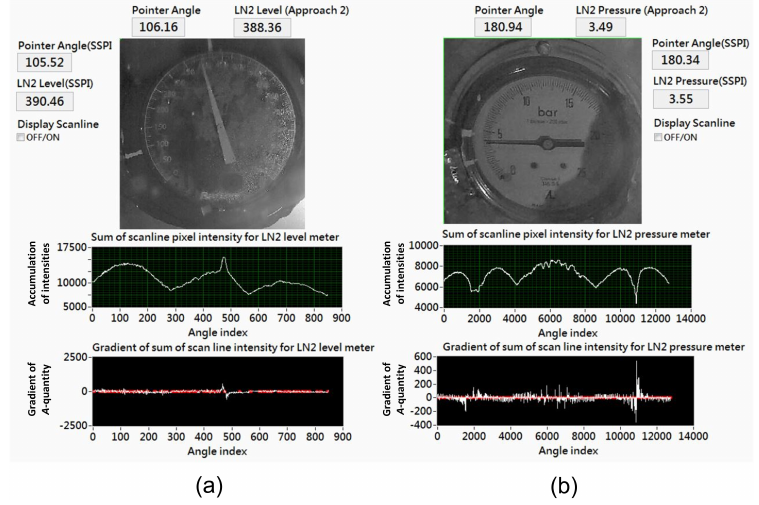
Figure 26. Results of reading ( a ) the level meter and ( b ) the pressure meter for the worst-case rainy night